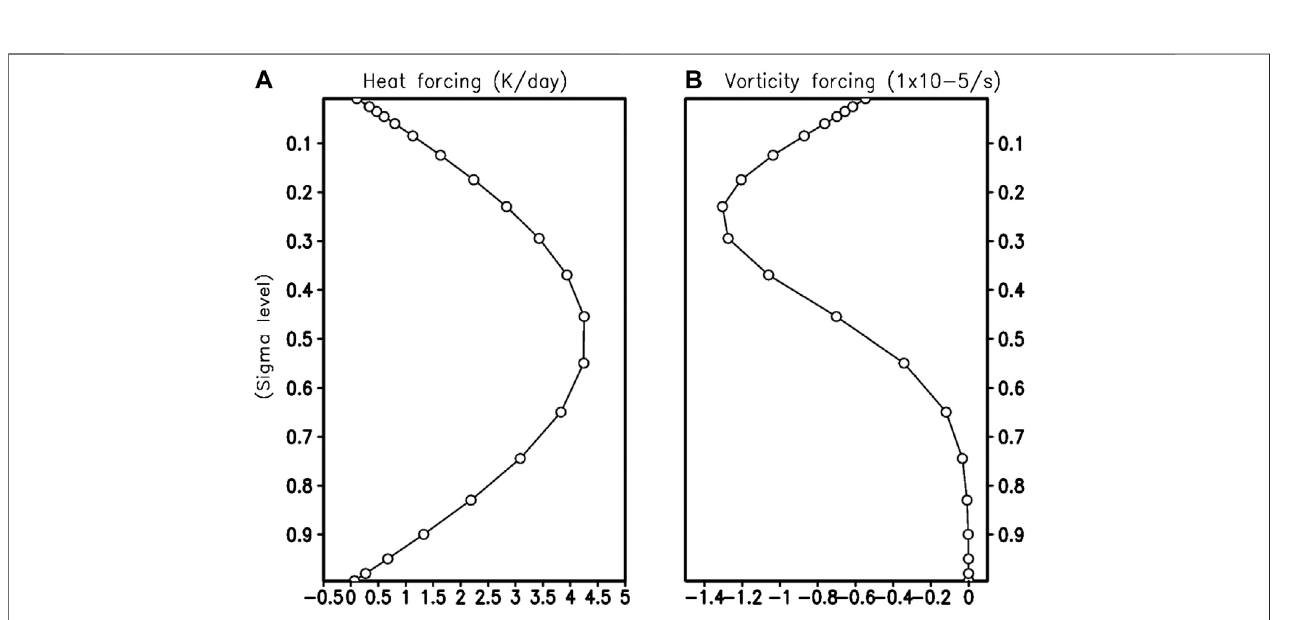
FIGURE 3 | Forcing centers for the LBM experiment. Red shading shows a prescribed forcing, and the forcing moves step by step to every grid on the Northern Hemisphere.